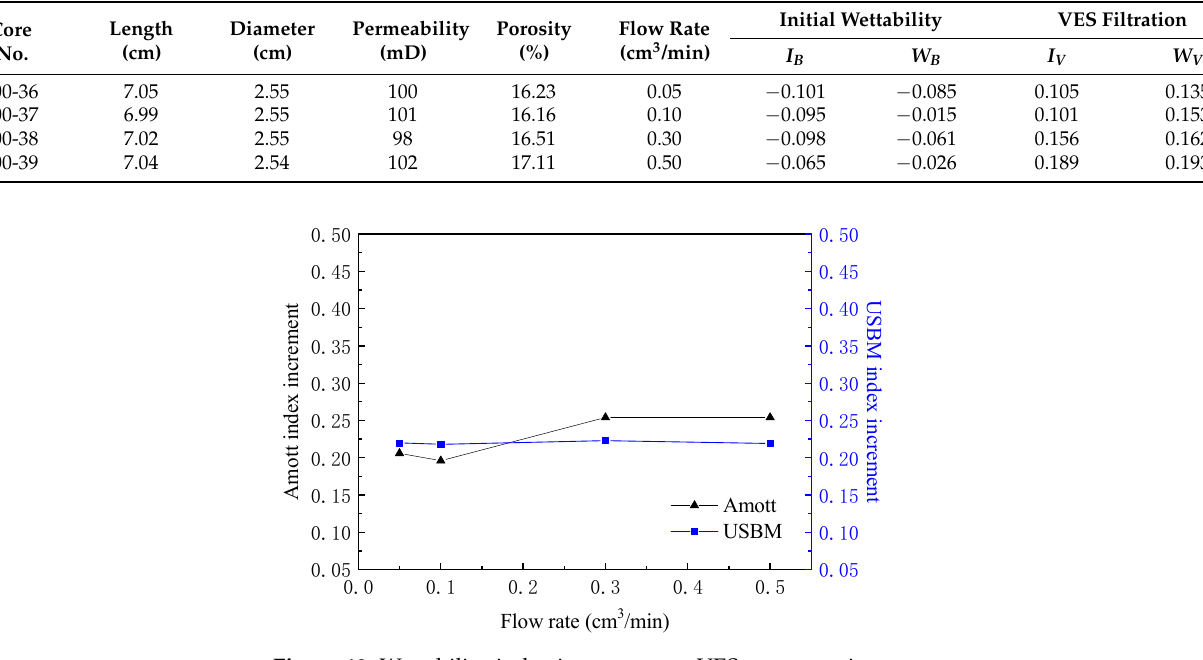
Table 6. Effect of pore radius on